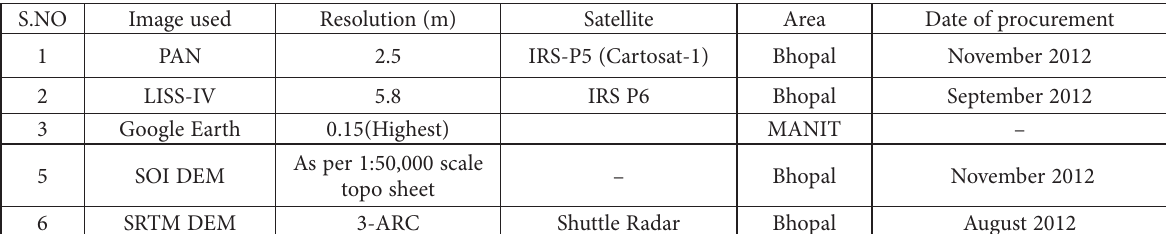
Table 1. Data resources